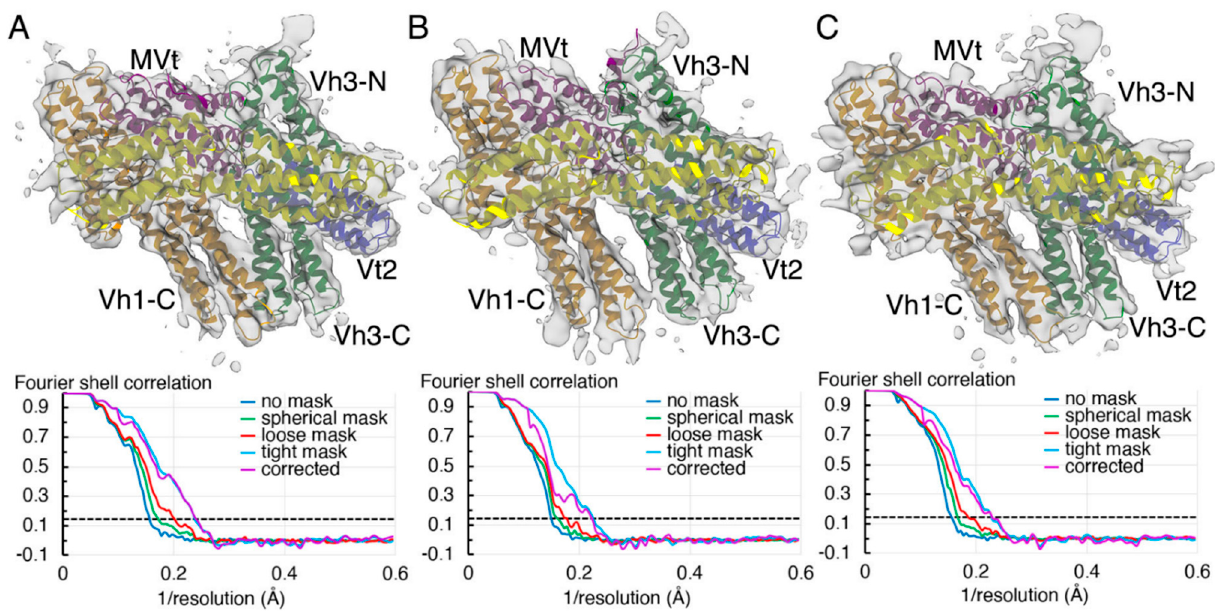
Figure 3. Coordinated metavinculin domain movements confers conformational flexibility. Our metavinculin structure derived from successive heterogeneous and homogeneous refinement elucidates discrete auto-inhibited conformations of metavinculin. The refined metavinculin conformer is colored spectrally (Vh1, orange; Vh2, yellow; Vh3, green; Vt2, blue; MVt, violet). The bottom panels show the gold standard Fourier shell coefficient derived from homogeneous refinement applying a 0.143 Å threshold limit for resolution estimation. ( A ) The 4.15 Å resolution H1’-parallel metavinculin structure is shown with an overlay of the corresponding refined model. ( B ) The 4.5 Å resolution H1’-kinked metavinculin structure exhibiting differently arranged subdomains is shown with an overlay of the corresponding refined model. ( C ) The 4.27 Å resolution H1’-parallel metavinculin structure is shown with an overlay of the corresponding refined model.